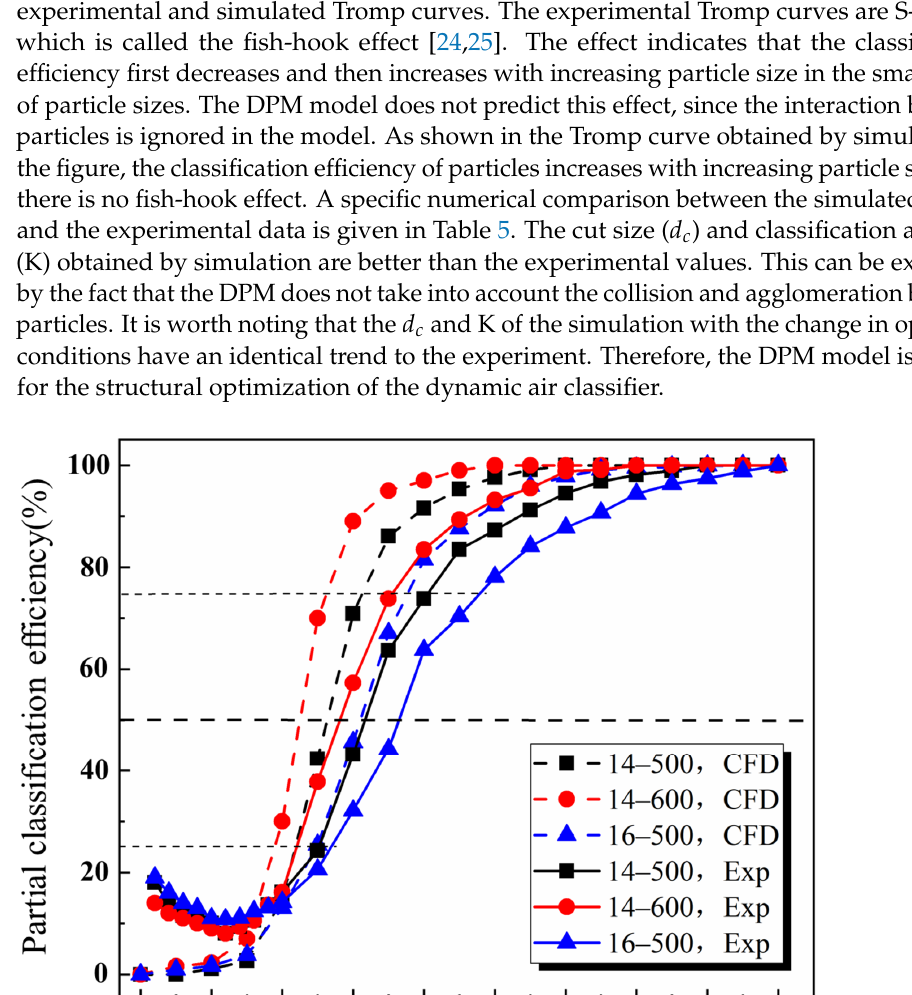
Table 4. Comparison of the pressure drop between the experiment and simulation.